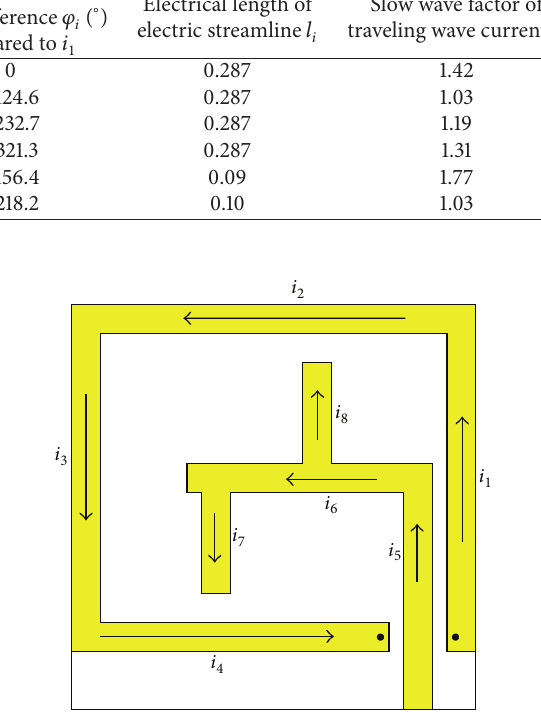
Figure 5: Schematic diagram of each current